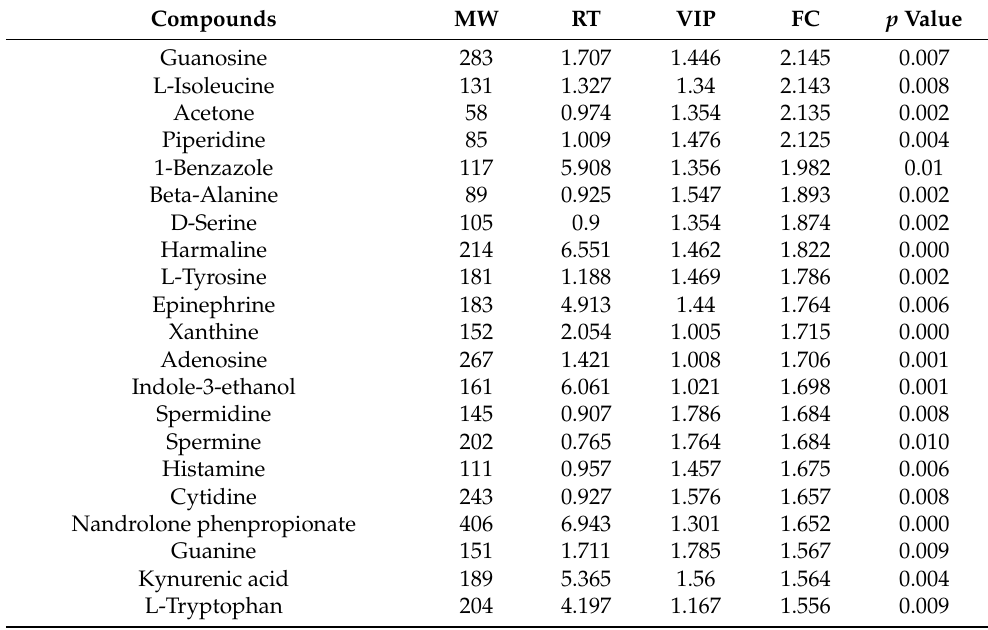
Table 8. Different metabolites content in the plasma of yaks fed low- and high-protein